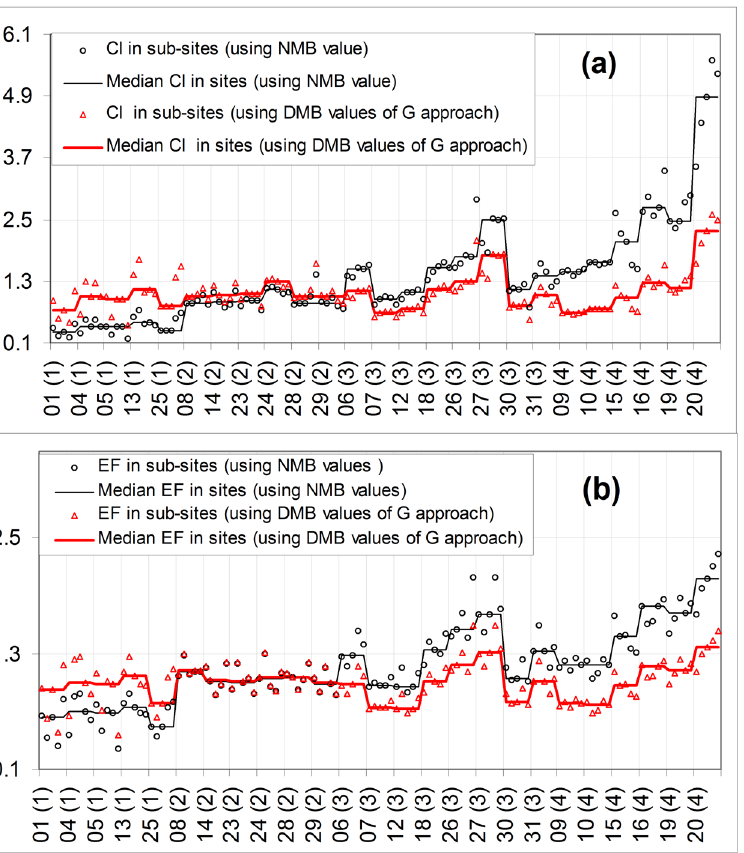
Figure 6: Values of contamination index ( a ) and enrichment factor ( b ) of Ni in sub - sites and sites using non - di ff erentiated median back - ground values and di ff erentiated median background values obtained by G approach for classi fi cation of sites ( LGs are in parentheses )